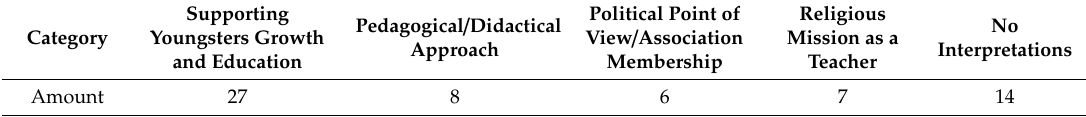
Table 1. Di ff erent ways of telling about a RE teacher’s career (62